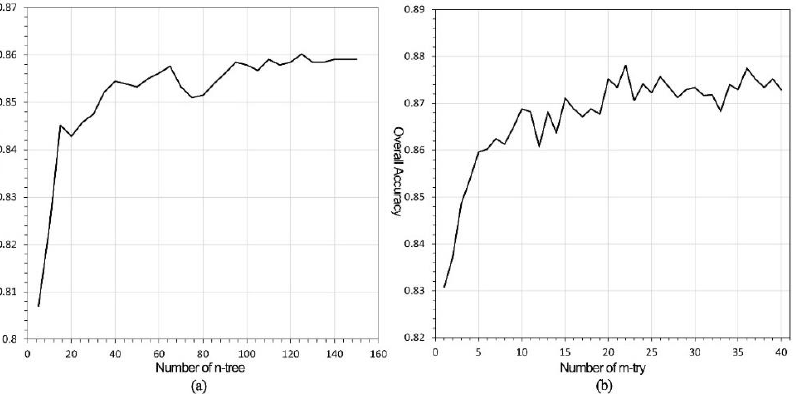
Figure 5. Debugging results for n-tree and m-try; the horizontal axis shows the numbers for n-tree or m-tree, and the vertical axis shows the overall classification accuracy of the RF model. ( a ) n-tree; ( b ) m-try.